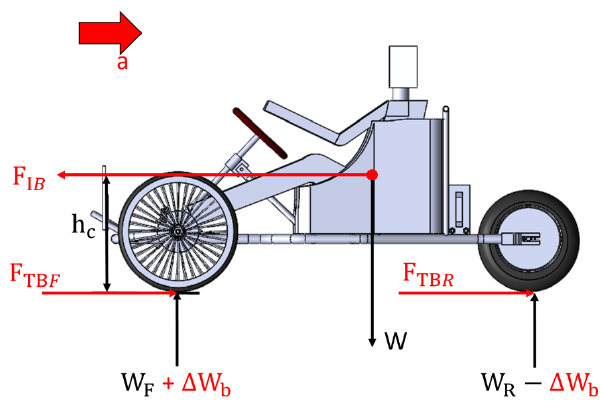
Figure 8. Full vehicle (with a person) model view.